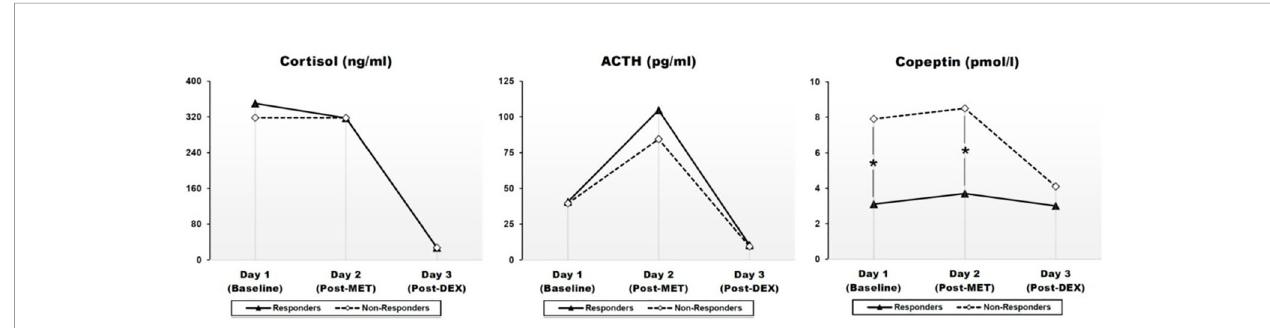
FIGURE 1 | Effects of metyrapone (MET) and dexamethasone (DEX) on cortisol (CORT), ACTH, and CoP in responders and non-responders to ESC antidepressant treatment. Graphic presentation of Table 2 . Pointwise values represent geometrical means adjusted for age, gender, BMI, history of previous depression and smoking. Group differences were assessed through a linear analysis of covariance (ANCOVA), controlling for age, gender, BMI, history of previous depression, and smoking. ACTH: Adrenocorticotropic hormone. Day 1: baseline; day 2: Post-MET: post-metyrapone; day 3: post-DEX: post-dexamethasone. A mixed between- within subject ANOVA indicated a highly signi fi cant effect of time (i.e. treatment condition) in all three measures with very large effect sizes, which con fi rmed the expected effects of each treatment condition ( cf . Results section). Group (response vs. non-response) had a signi fi cant effect only for CoP, but not for CORT or ACTH, suggesting a statistically signi fi cant difference between responders and non-responders on CoP levels across days 1 – 3 ( cf . Results section). * p < 0.05.